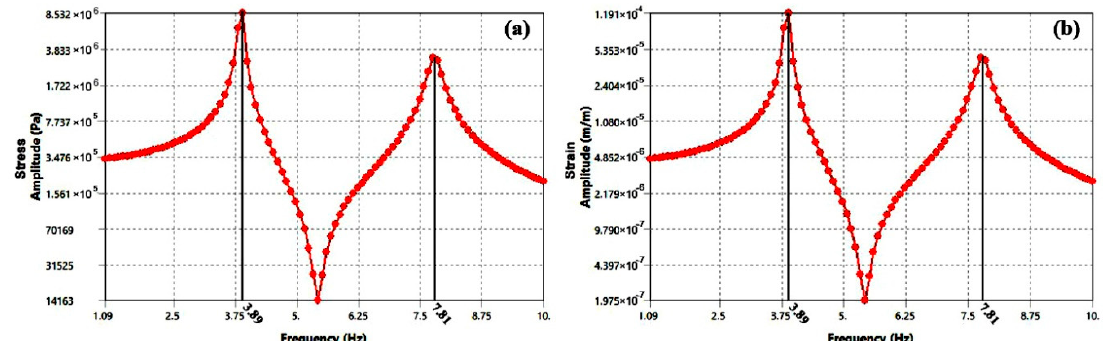
Figure 4. Frequency responses of MRPEH ( a ) stress and ( b ) strain obtained from FEA under 0.2 g base excitation.